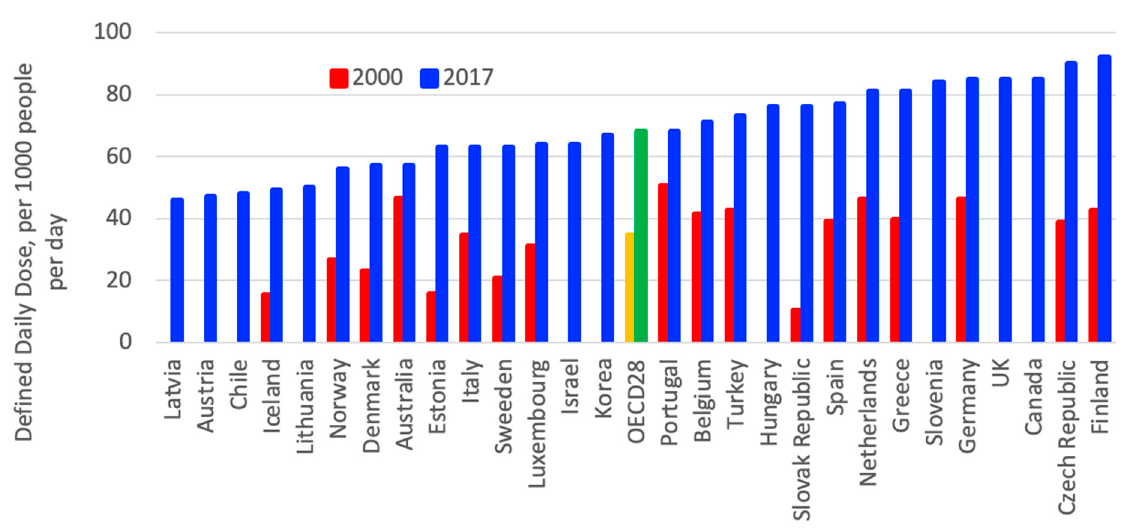
Figure 10. Consumption of antidiabetic drugs in OECD countries from 2000 to 2017 [3].